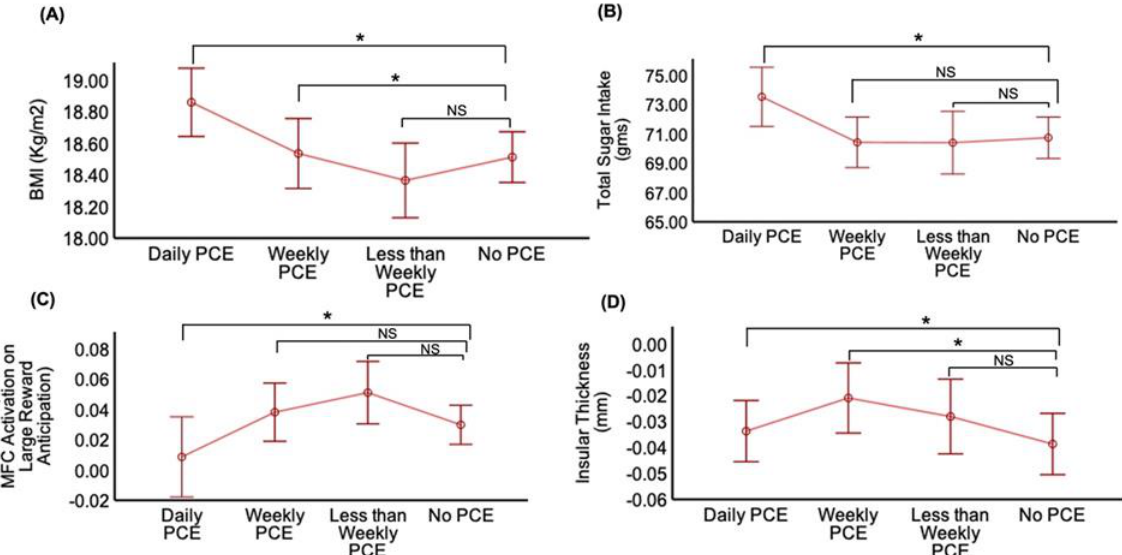
Figure 1. Line plots illustrating the association outcomes of BMI ( A ), total sugar intake ( B ), rostral middle frontal cortex activation on large reward anticipation during MID task-fMRI ( C ), insular thickness ( D ) in various prenatal caffeine exposure (PCE) (vs. no PCE) groups after controlling for the confounding effects of age, sex, child race/ethnicity, highest household education, household income and physical activity across different on linear mixed effect models. Here, * denotes statistical significance with p < 0.05 on Bonferroni correction, while NS denotes no statistical significance.